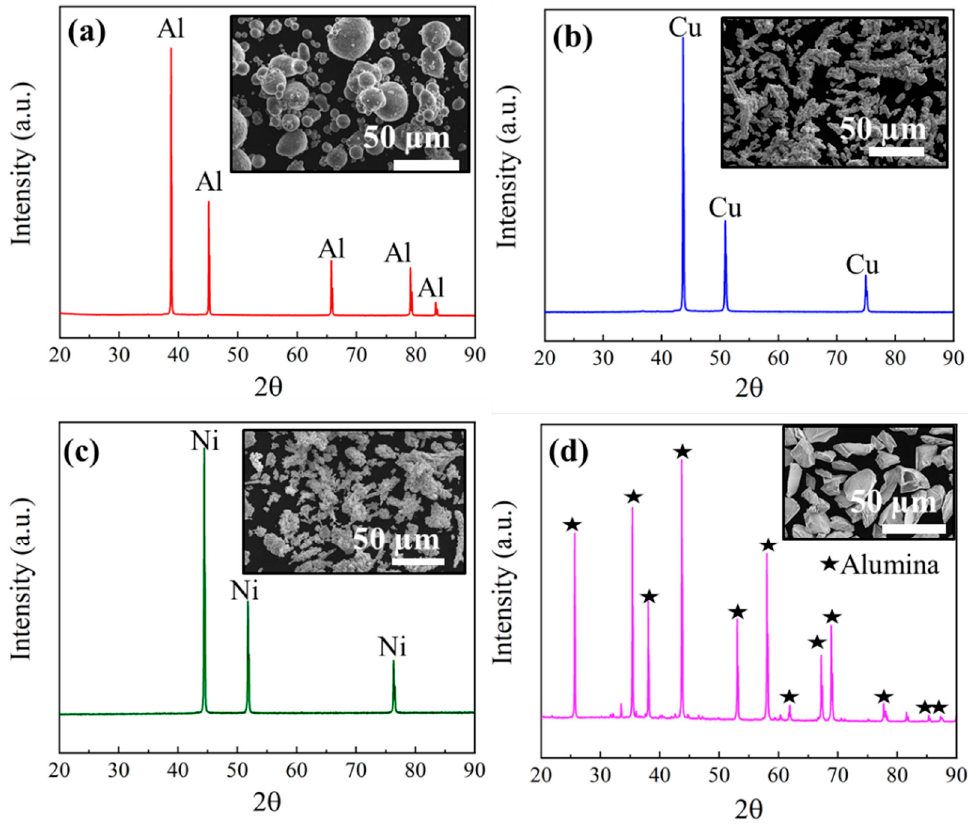
Figure 2. Morphology and phase distribution of the feedstock powders used in the study ( a ) Al, ( b ) Cu, ( c ) Ni, and ( d ) Alumina.